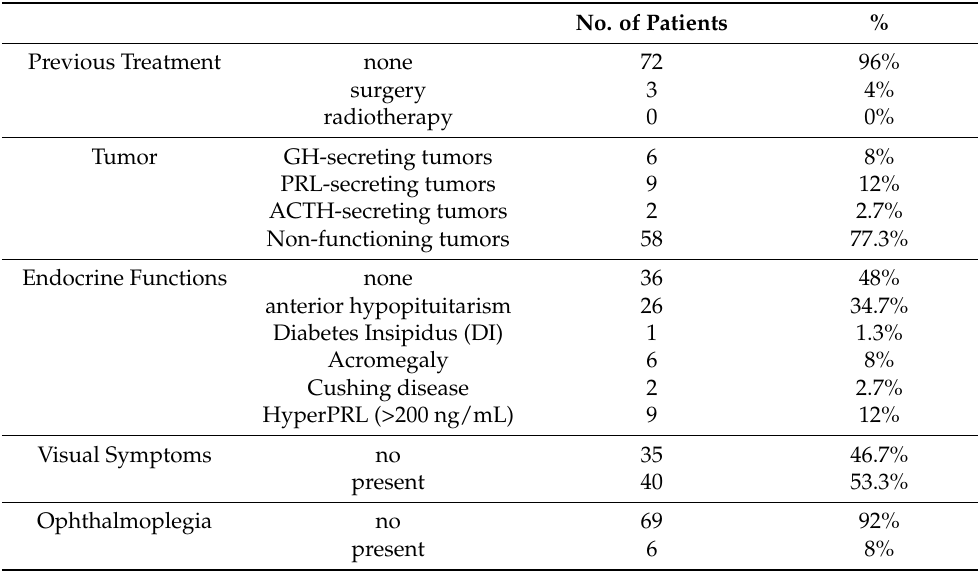
Table 1. Patients’ pre-operative features. GH = growth hormone; PRL = prolactin; ACTH = adreno- corticotropic